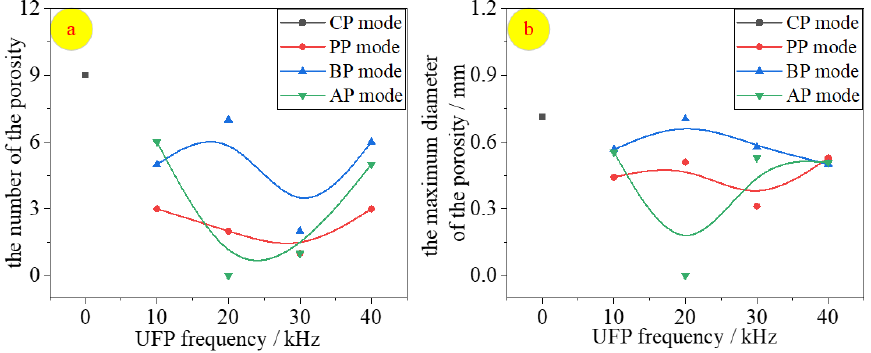
Figure 4. Porosity quantity ( a ) and the maximum diameter ( b ).